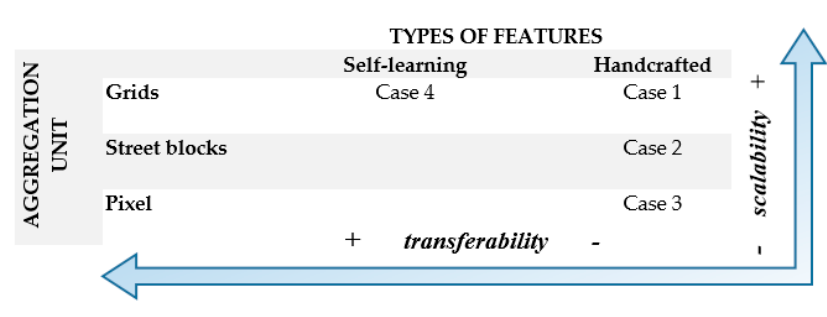
Figure 9. Comparison of cases (Section 3.2) on their roles for addressing scalability and